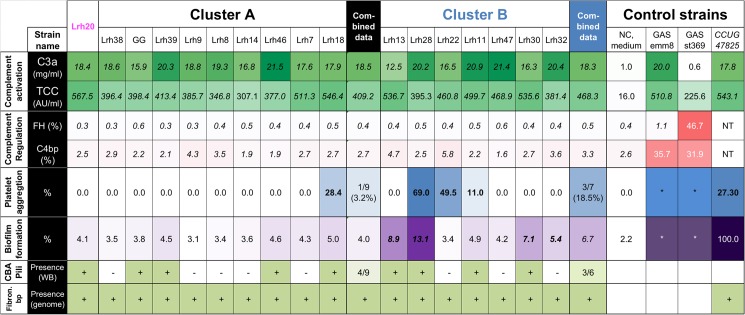
A heatmap of phenotypic features of the L. rhamnosus strains measured in vitro.Combined data represent average values or numbers of the strains detected in clusters A and B. NC equals negative control containing buffer in the assays, GAS group A streptococcus, NT not tested, asterisk* equals values that are representative from literature but not tested here for platelet aggregation [36] and biofilm formation [37], TCC equals terminal complement complex, FH factor H, C4bp complement C4b binding protein, CBA SpaC, SpaB and SpaA pilin subunits and fibron. bp equals fibronectin/fibrinogen binding protein. Bold and Italic letters equal significant value, p<0.05 for biofilm formation compared to L. rhamnosus GG (GG). Color intensities indicate the level of the values: green for complement activation measured as C3a and TCC, red for binding of complement regulators, blue for platelet aggregation, purple for biofilm formation and light green express the presence of SpaCBA pilus determined by Western blot using anti-SpaA antibody and fibronectin/fibrinogen binding protein at genome.